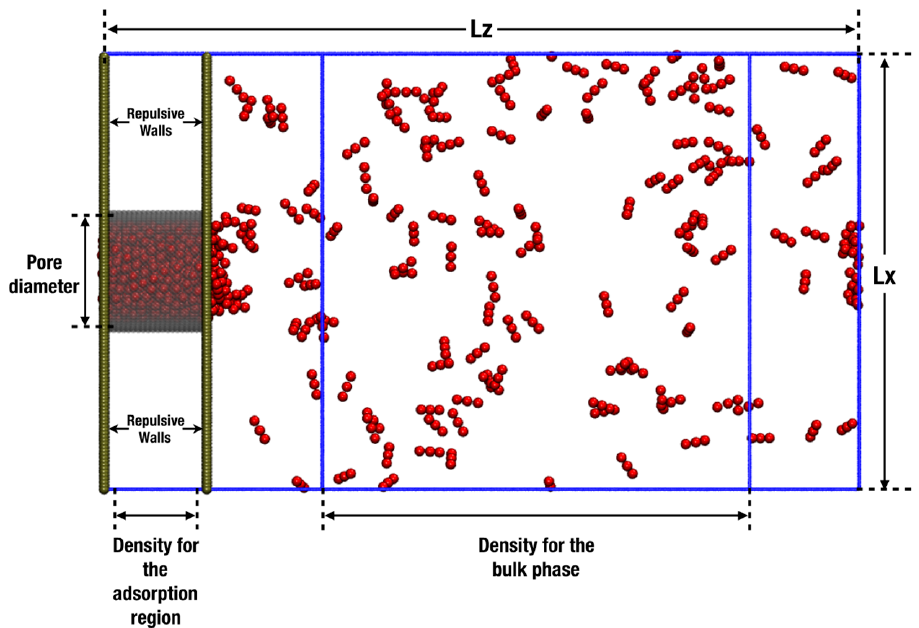
Figure 4. Schematic representation of the simulation box used to obtain the adsorption isotherms and the bulk density. Periodic boundary conditions are applied in all Cartesian directions.